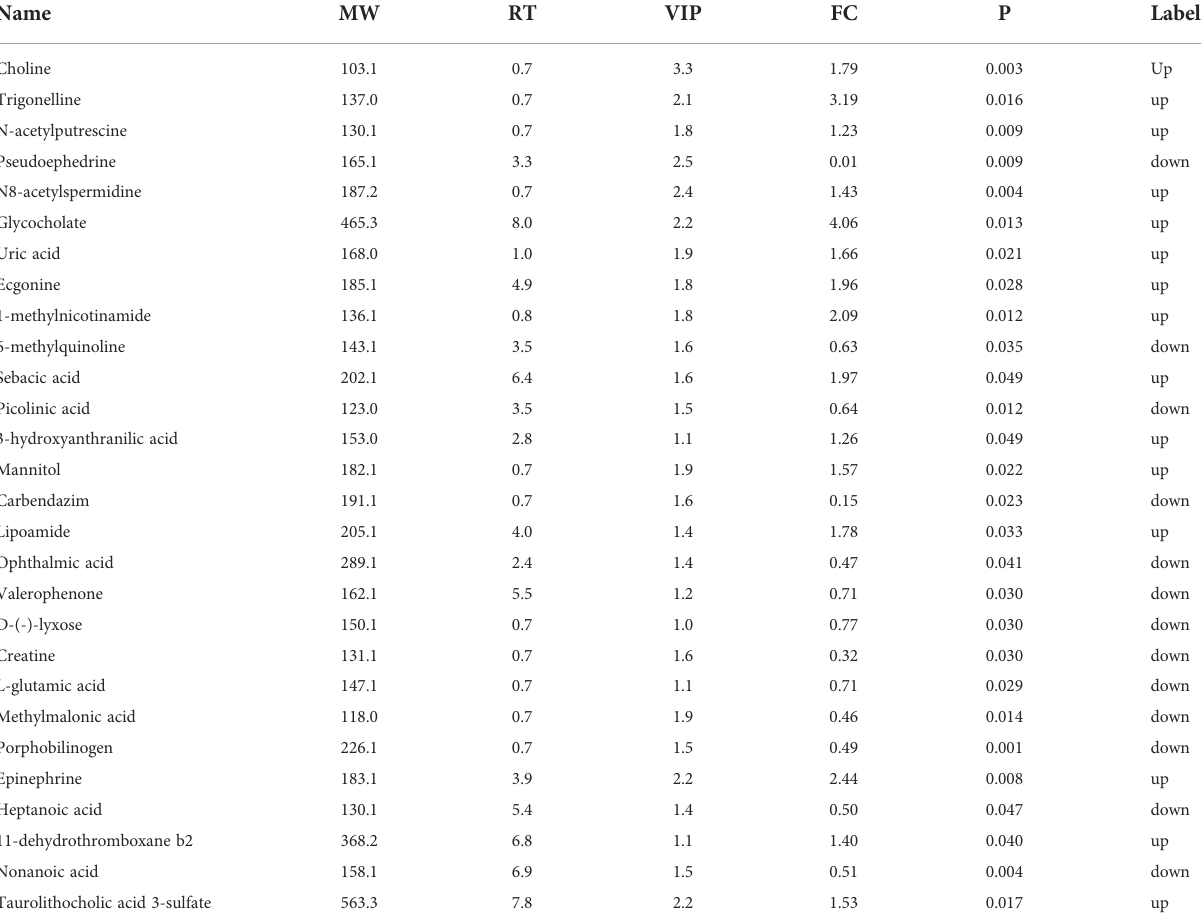
TABLE 3 Identi fi ed differential metabolites between two groups.